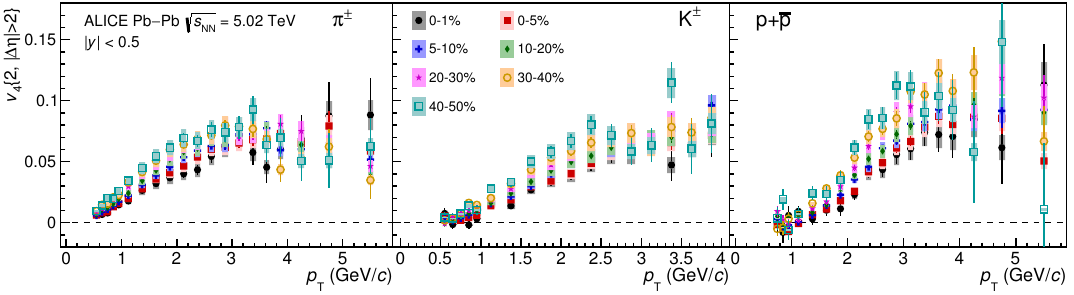
Figure 3 . (Colour online) Centrality dependence of v 3 ( p T ) for (cid:25) (cid:6) , K (cid:6) , p+p, (cid:3)+(cid:3), and K 0 Statistical and systematic uncertainties are shown as bars and boxes, respectively.